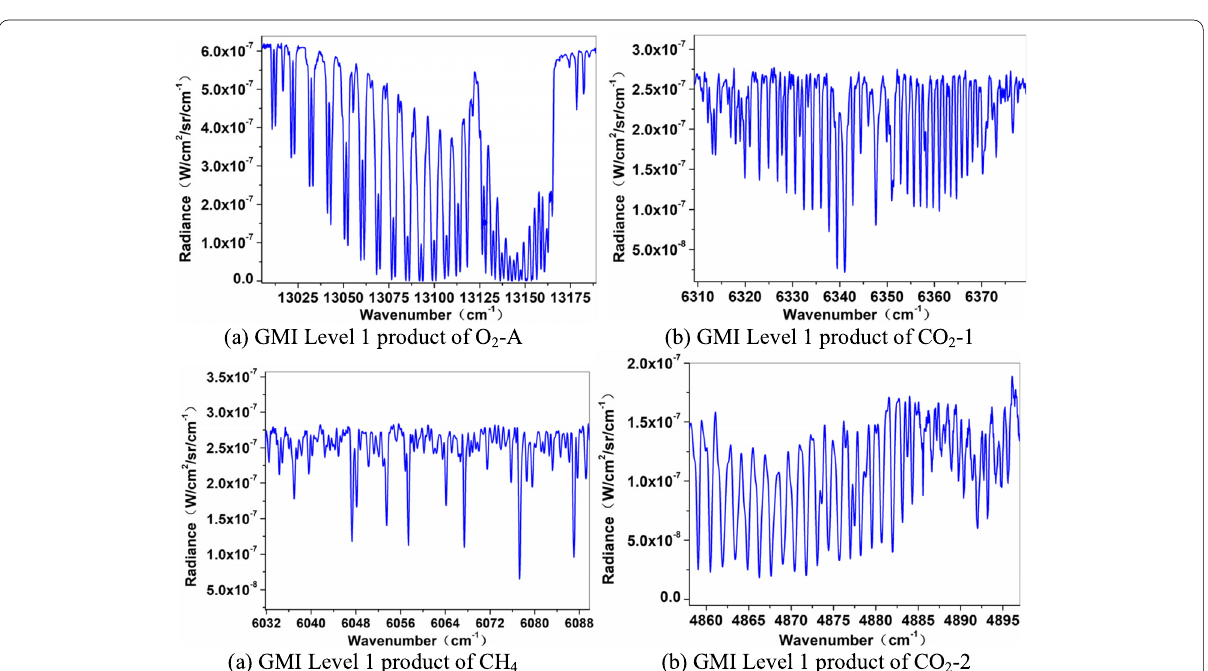
Fig. 2 The spectral of GF-5/GMI. a GMI Level 1 product of O 2 -A. b GMI Level 1 product of CO 2 -1. a GMI Level 1 product of CH 4 . b GMI Level 1 product of CO 2